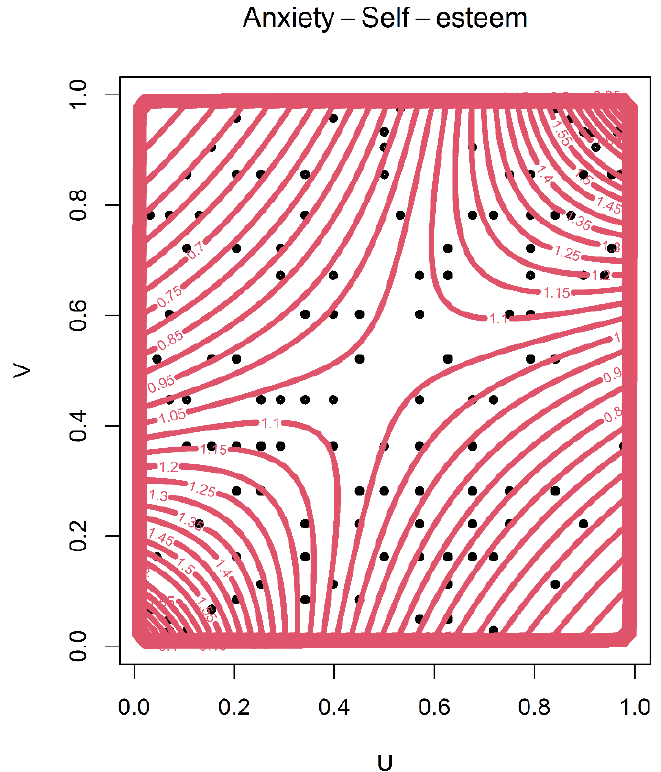
Figure 1. The contour plot of the Frank copula with scatter plot of the joint anxiety and the self- esteem combinations.